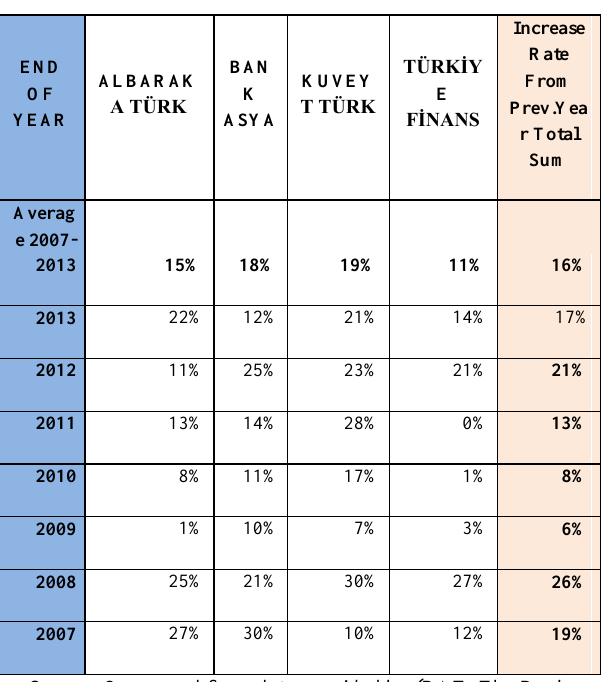
Table-4/b: The Average Personnel Number For